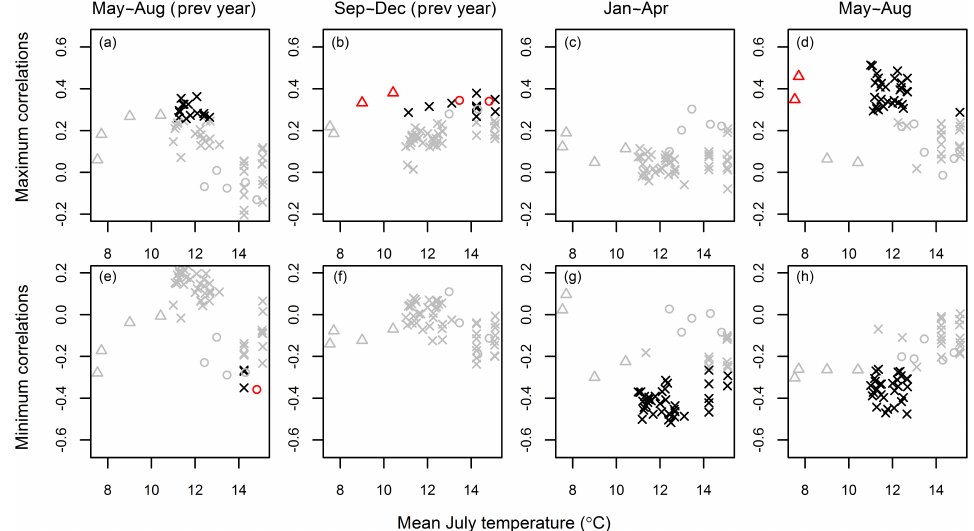
Figure 7. The magnitude of the maximum (largest positive) ( a–d ) and minimum (largest negative) ( e–h ) correlations between the RWIs and monthly mean temperatures in different seasons (columns) against the mean July temperature of each plot. The black X’s denote the plots in Finland and the plots on the south-central Tibetan Plateau (SCTP) are marked with red circles and on the southeastern Tibetan Plateau (SETP) with red triangles. The grey colour indicates correlations not significant at the 5%